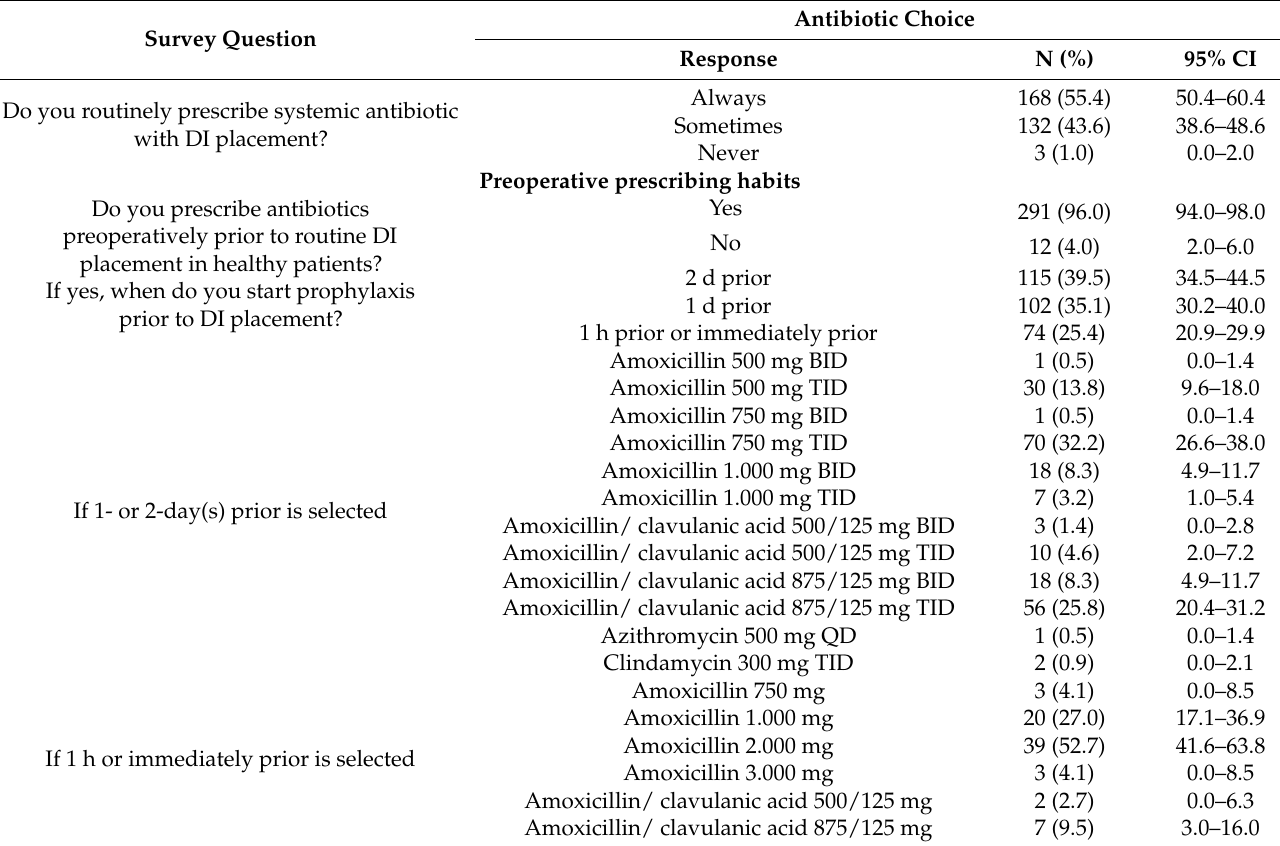
Table 4. Summary response by